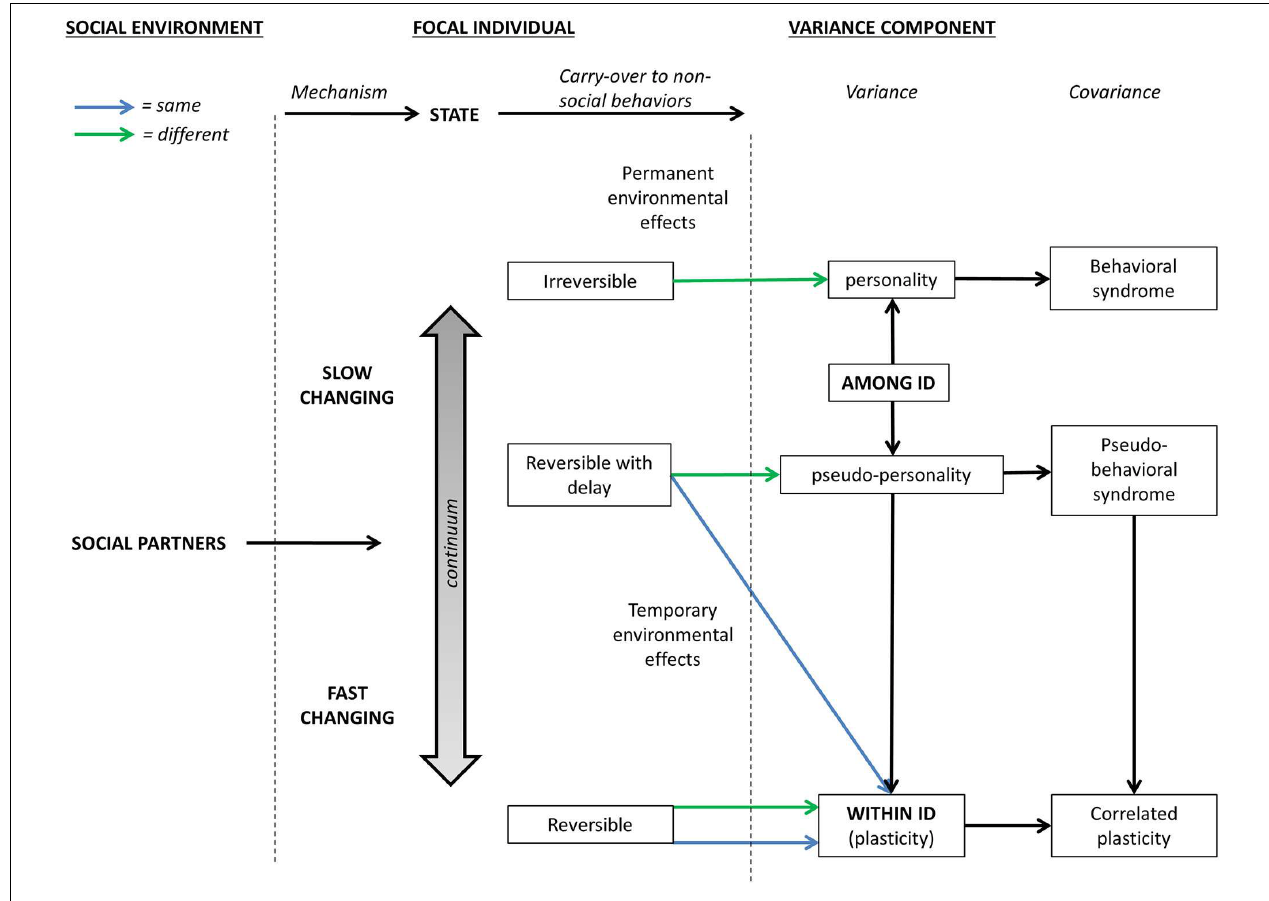
FIGURE 2 | Schematic presentation of how the social-carry-over effects affect within- and among-individual variance components in behaviors expressed in non-social contexts through state